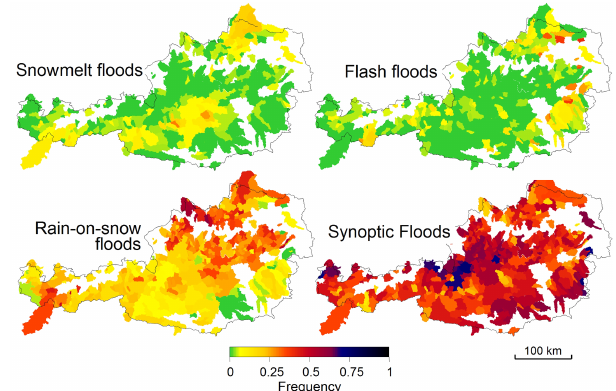
Figure 7. Frequency of regional flood process types in Austria based on observed maximum annual peak discharges of 12000 events classified according to their type. Each polygon represents a gauged catchment. From Merz and Blöschl (2003).